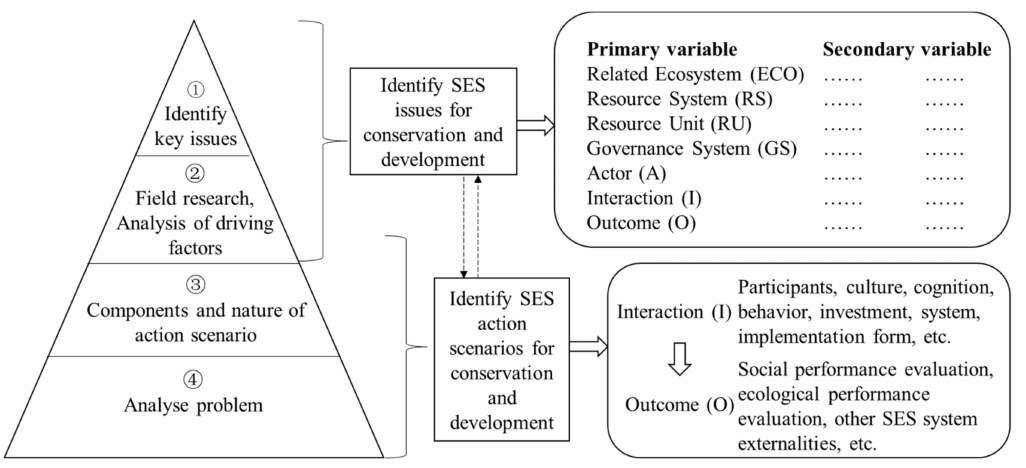
Figure 3. Problem-oriented social-ecological system (SES) framework